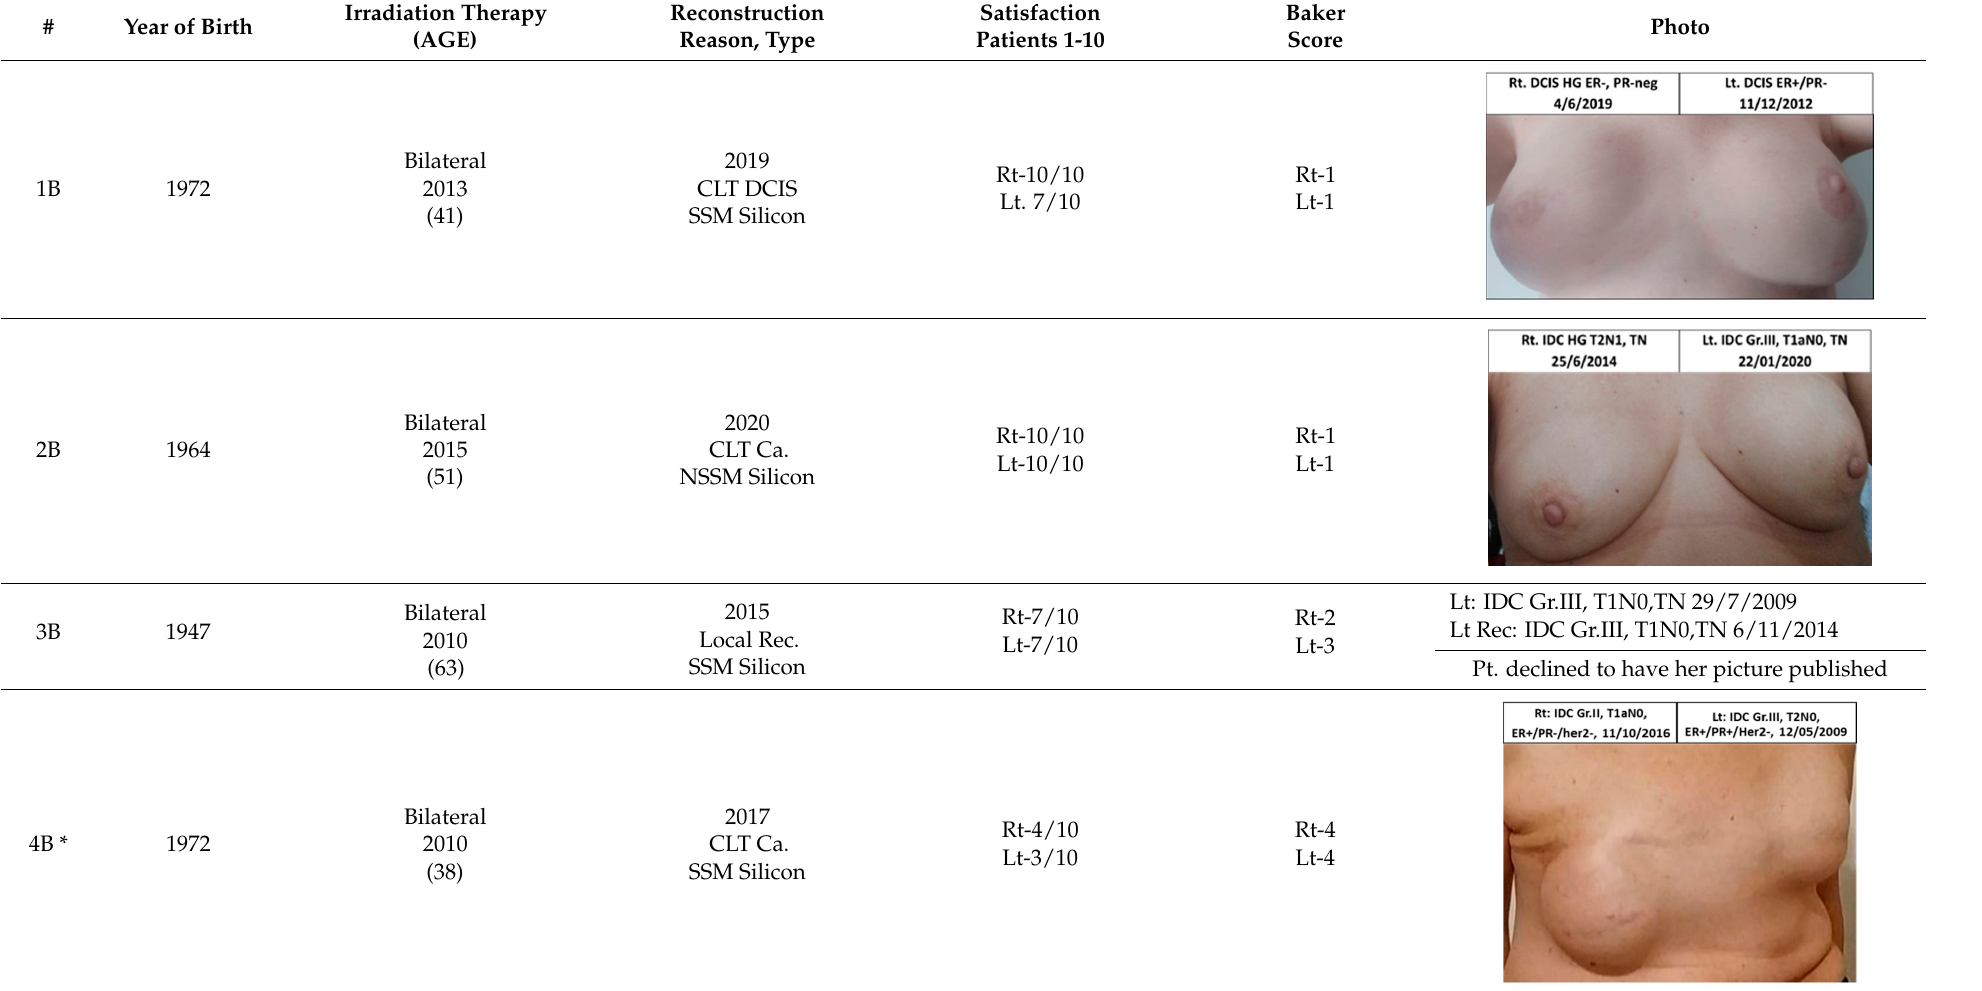
Table 2. Mastectomy and reconstruction of non-irradiated breasts. Irradiation Reconstruction Therapy Birth Reason, Type (AGE)